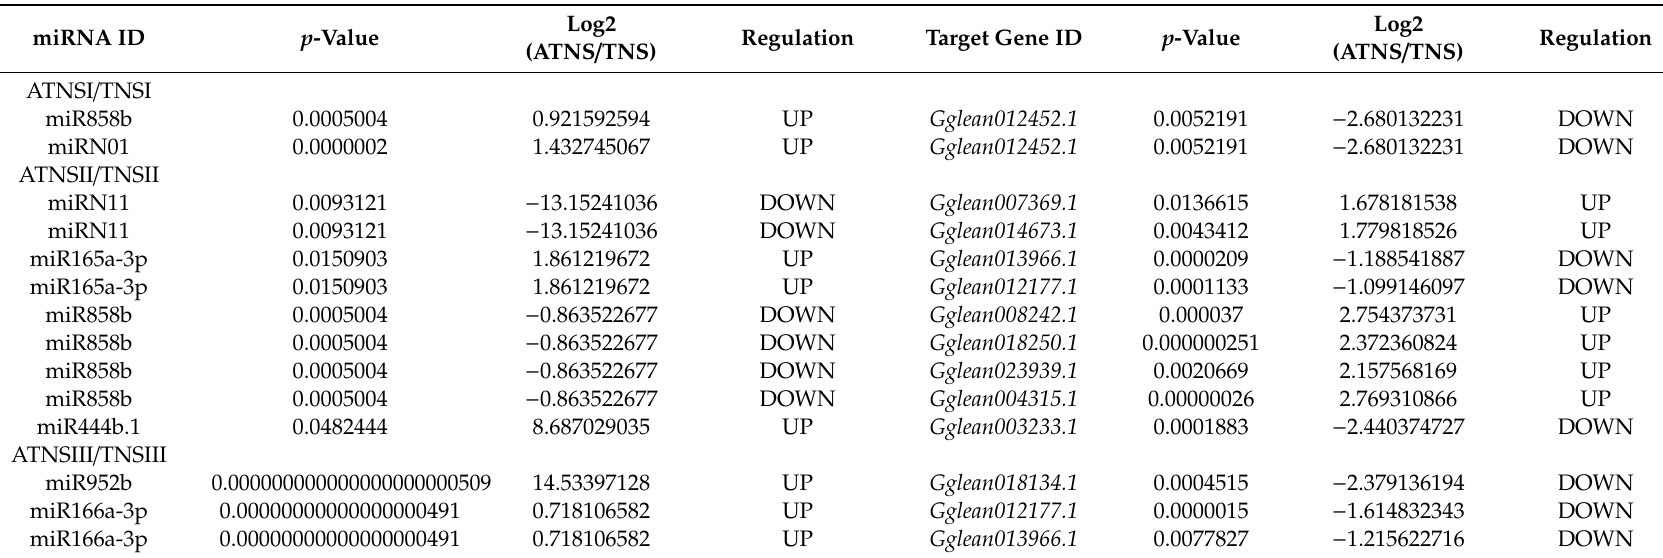
Table 1. Predicted mRNA targets of di ff erentially expressed miRNAs in ATNSI_TNSI, ATNSII_TNSII, and ATNSIII_TNSIII. Note: UP represents upregulation and DOWN represents